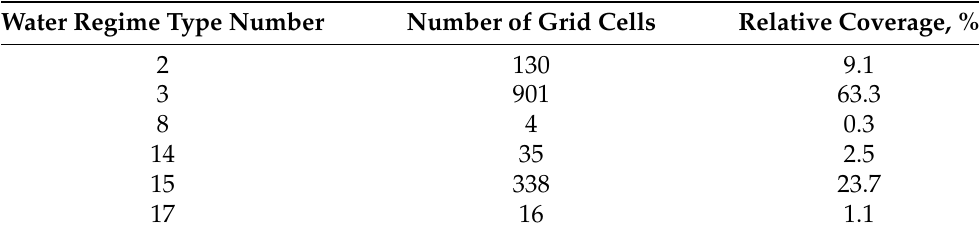
Table 2. Characteristics of the spatial distribution of the presented water regime